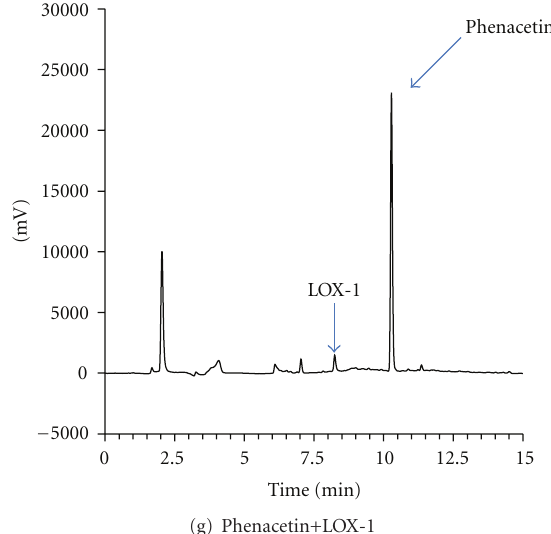
Figure 2: Representative chromatograms of PI polyamides at the LLOQs: (a) blank (with the IS), (b) HN.49, (c) TGF- β 1f, (d) TGF- β 1t, (e) HN.50f, (f) HN.50t, and (g) LOX-1.